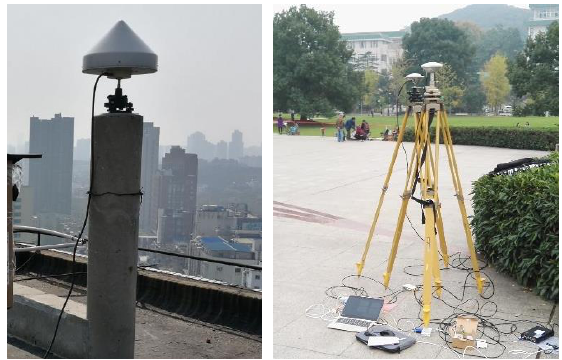
Figure 4. Data acquisition scenario (( left ) reference station, ( right ) rover station).